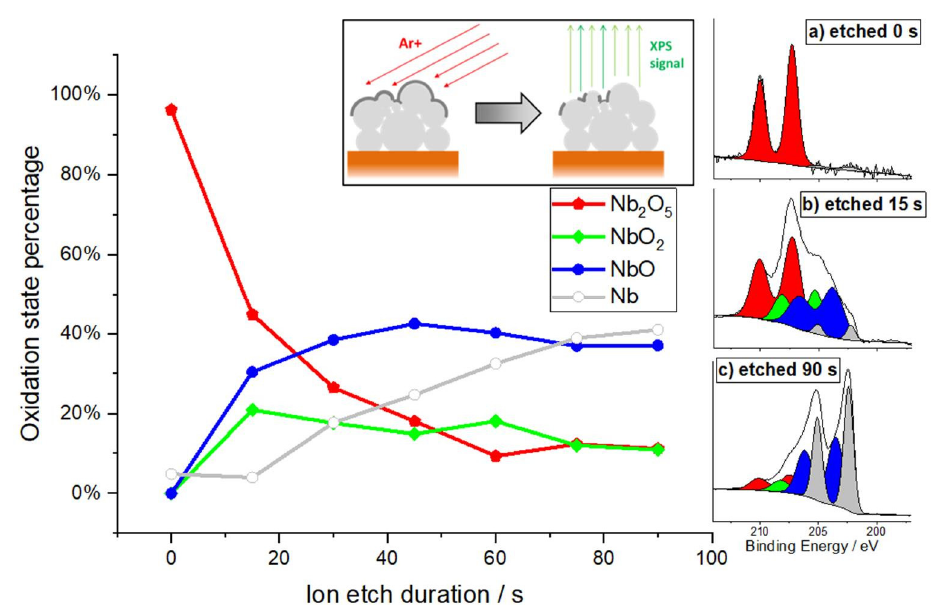
Figure 6. XPS depths profile of the oxide layer: The oxide layer of the Niobium coating is etched/reduced under Ar + ion beam until steadiness is reached after ~90 s. Some areas of the grainy porous surface are hidden from the beam and lead to a remaining oxide signal. High resolution XPS spectrum after etching times of: ( a ) 0 s; ( b ) 15 s and ( c ) 90 s.